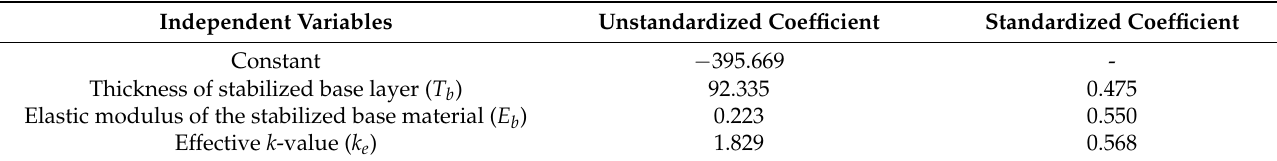
Table 6. Regression coefficients for composite k